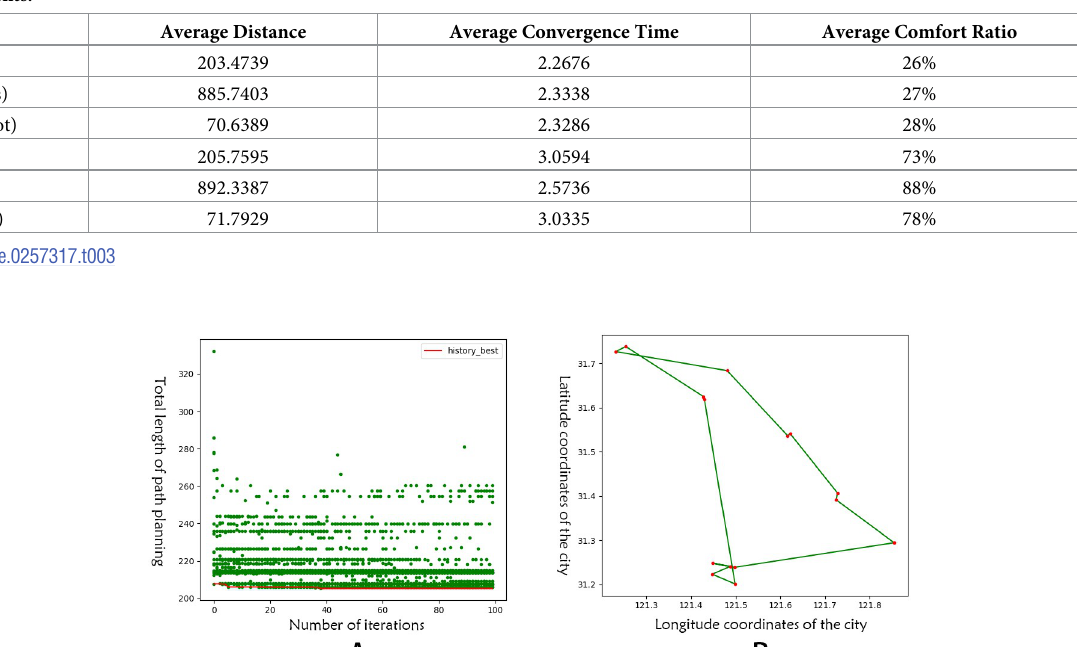
Table 3. The results of experiments.